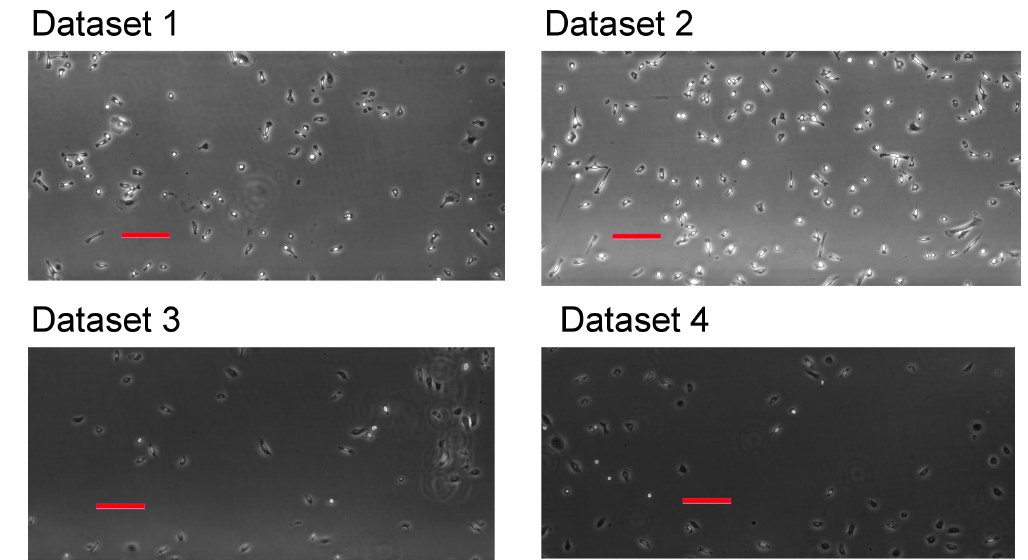
Figure 1. The first frames from each dataset. See main text for description of the datasets. Bars are 200 µ m in